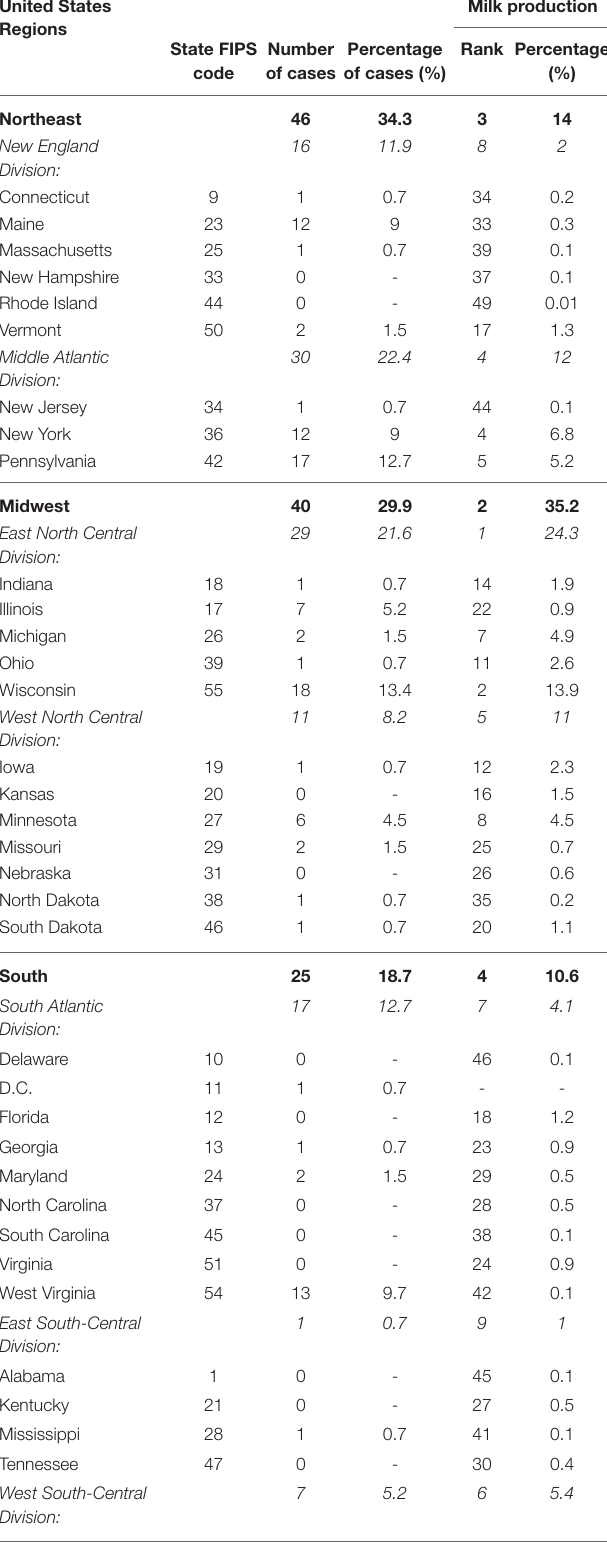
TABLE 1 | Regional/divisional analyses. United States Regions